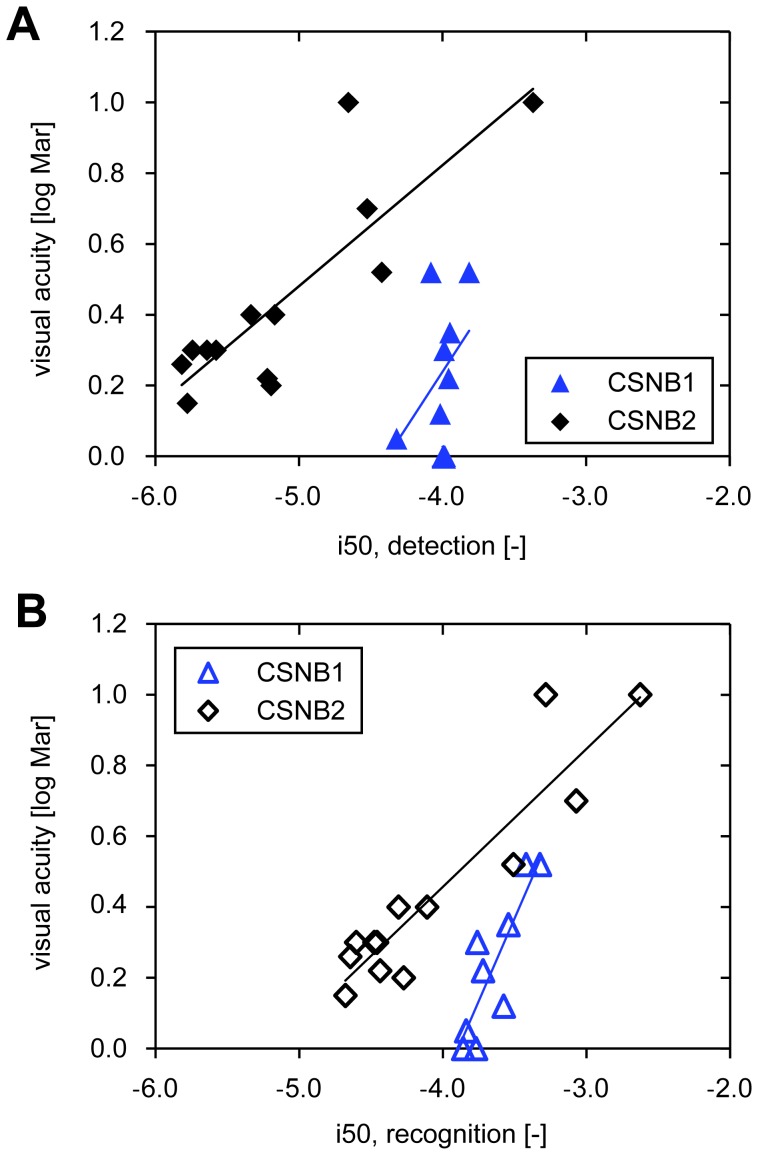
Linear regression between the intensity at which 50% of the objects were detected (i50d) or recognized (i50r) and the visual acuity.The lines resemble the simple linear regression fits. A: The Pearson correlation coefficient for i50d and the visual acuity was R = 0.84, p<0.01 for the CSNB2 patients, and R = 0.41, p>0.05 for the CSNB1 patients. B: The Pearson correlation coefficient for i50r and the visual acuity was R = 0.92, p<0.01 for the CSNB2 patients, and R = 0.86, p<0.01 for the CSNB1 patients.